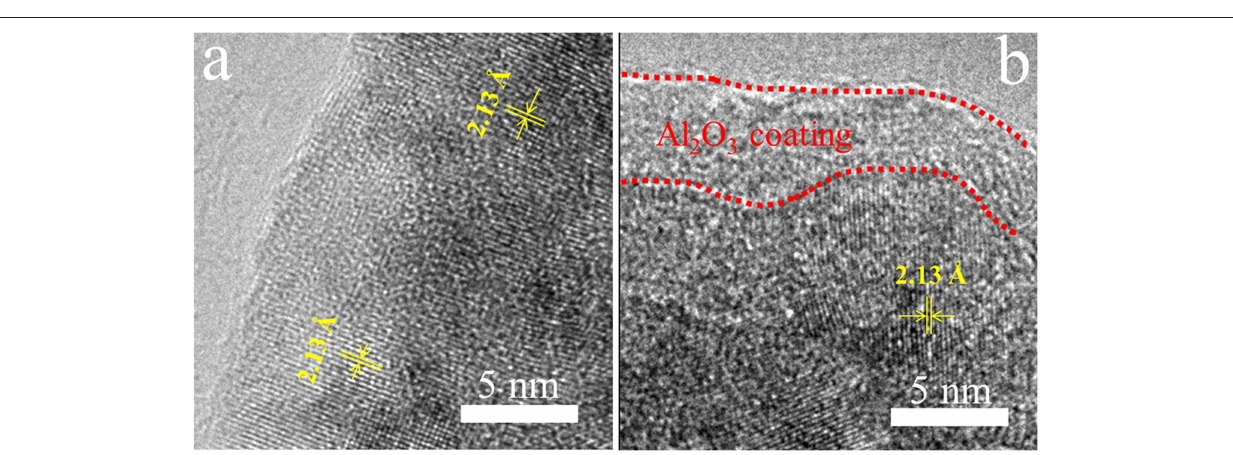
while the over-thick Al 2 O 3 layer leads to the reverse effect on the electrode. Figure 6 show the cyclic voltammetric (CV) curves of LTMO and LTMO/24Al 2 O 3 samples in the first three cycles at